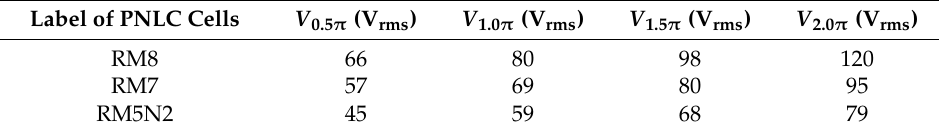
Table 2. Typical voltages of phase modulations in the three fabricated phase modulators. Label of PNLC Cells